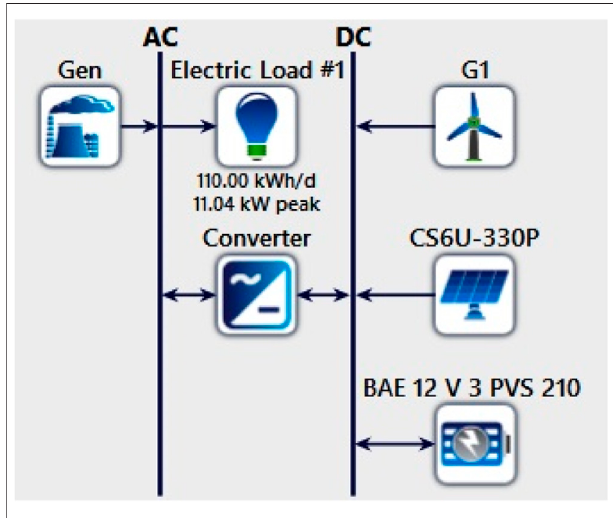
FIGURE 5 | Design of a hybrid system in HOMER.